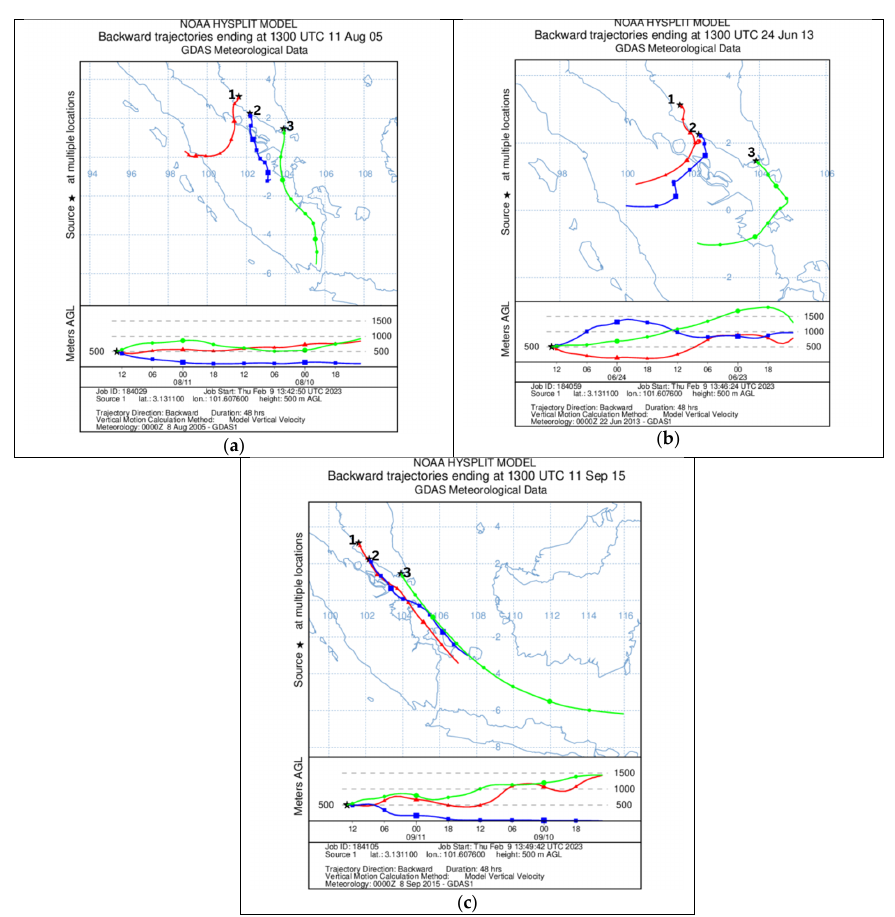
Figure 5. 48 h backward trajectories in Petaling Jaya, Melaka, and Pasir Gudang in ( a ) 2005, ( b ) 2013, and ( c ) 2015. Number 1 represents Petaling Jaya; 2 is Melaka; and 3 is Pasir Gudang.